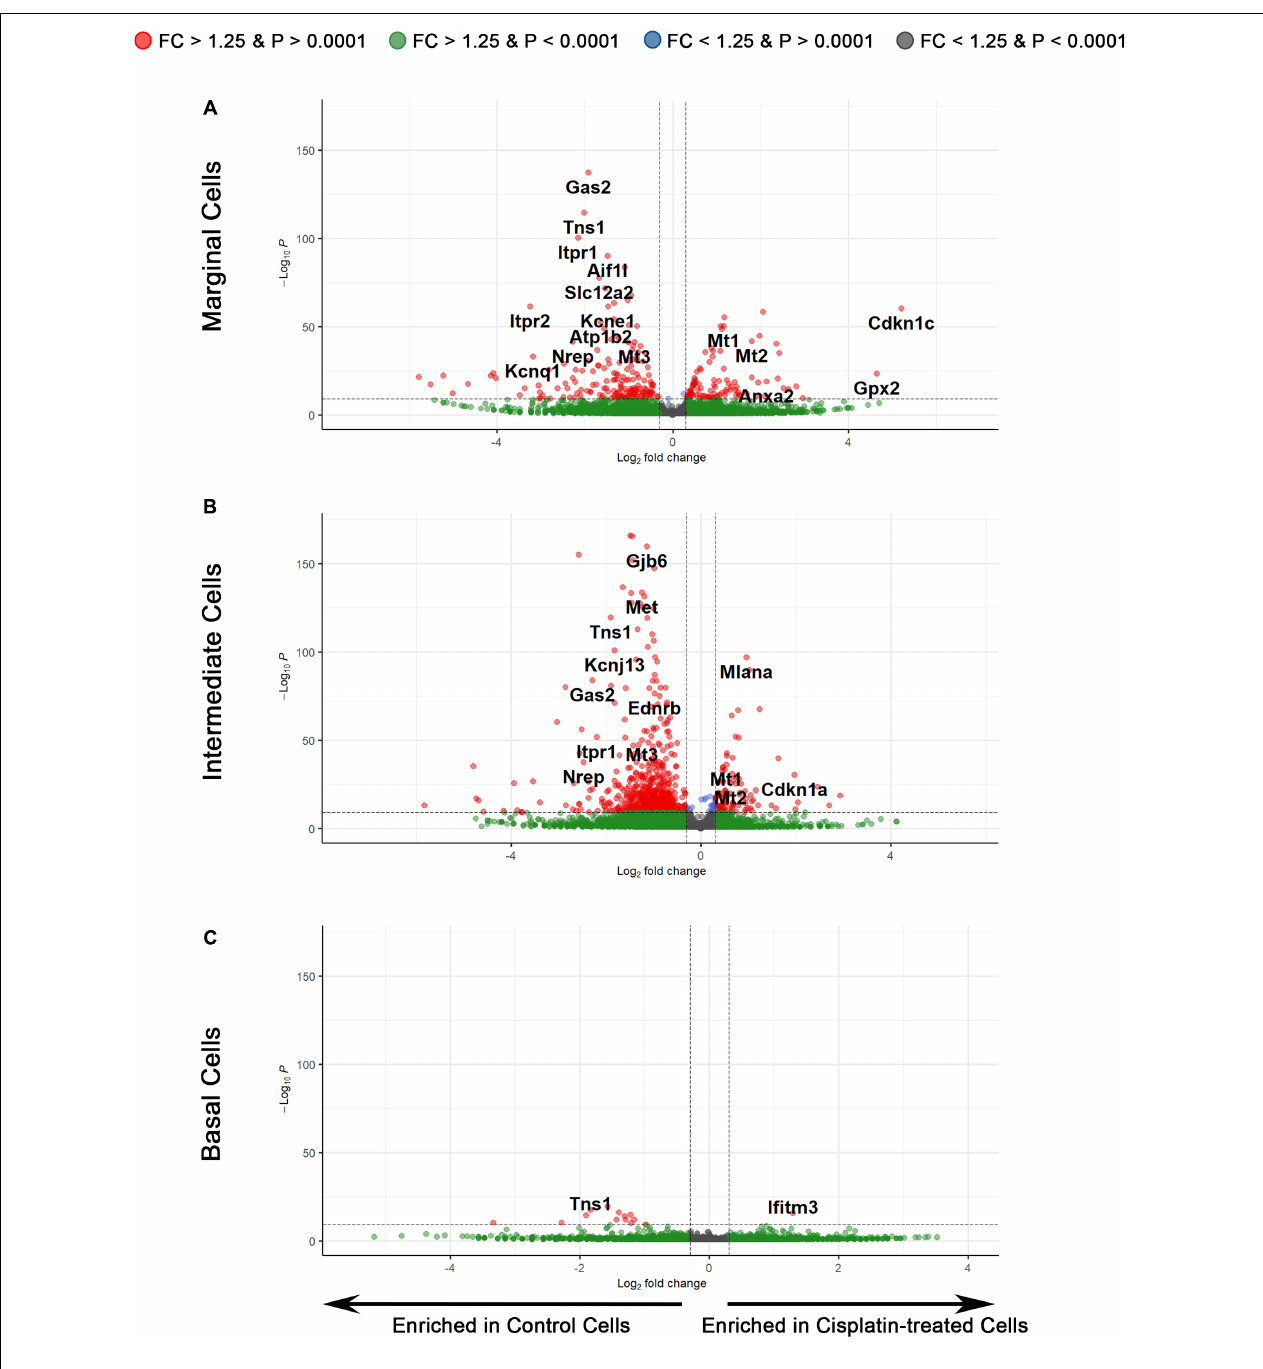
FIGURE 5 | Differential expression analysis reveals the transcriptomic changes in individual cell types of the SV after cisplatin treatment. (A) Volcano plot depicting differential gene expression between the scRNA-Seq data of marginal cells of control and cisplatin-treated mice. Genes are represented by circles, with genes enriched in cisplatin-treated SV cells to the right and genes enriched in control SV cells to the left. Positive and negative fold-change thresholds (FC ± 1.25) in log2 scale are represented by the vertical dotted lines. The p -value threshold ( p -value ± 0.0001) in –log10 scale is represented by the horizontal dotted line. Red circles are genes that exceed both fold change and p -value threshold criteria. Green circles are genes that exceed the fold change threshold but not the p -value threshold. Blue circles are genes that exceed the p -value threshold but not the fold change threshold. Gray circles are genes that do not meet either threshold criteria. (B) Differential gene expression between the scRNA-Seq data of intermediate cells of control and cisplatin-treated mice. (C) Differential gene expression between the scRNA-Seq data of basal cells of control and cisplatin-treated mice.